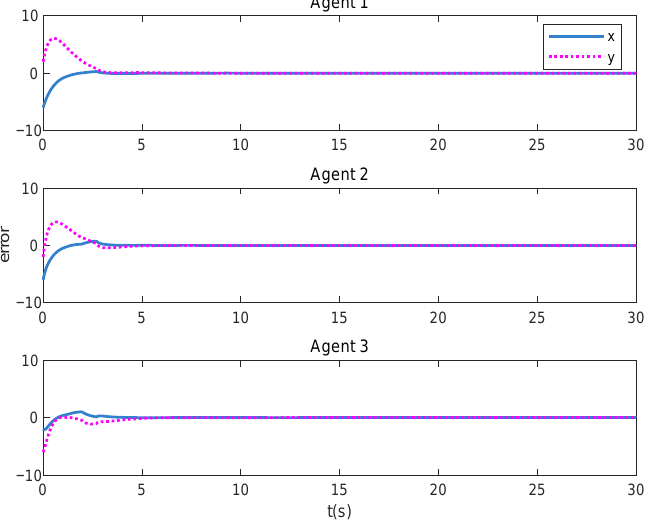
Figure 4. Errors between target agent and each tracking